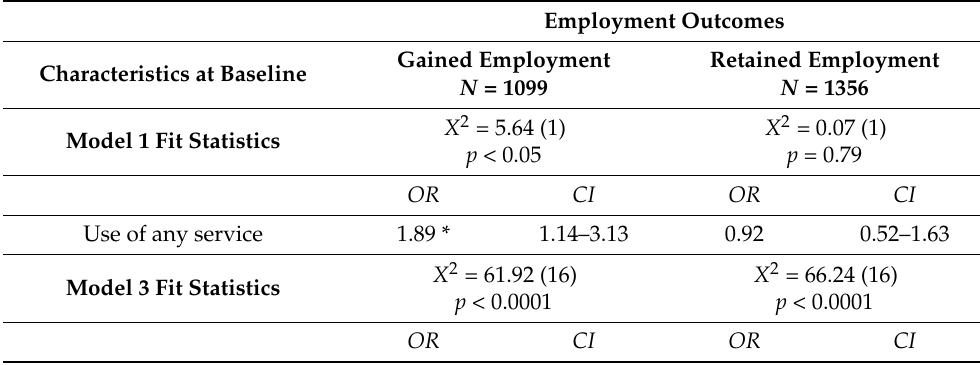
Table 2. Regression Analyses Predicting Employment Outcome: Any Use of Services. Employment